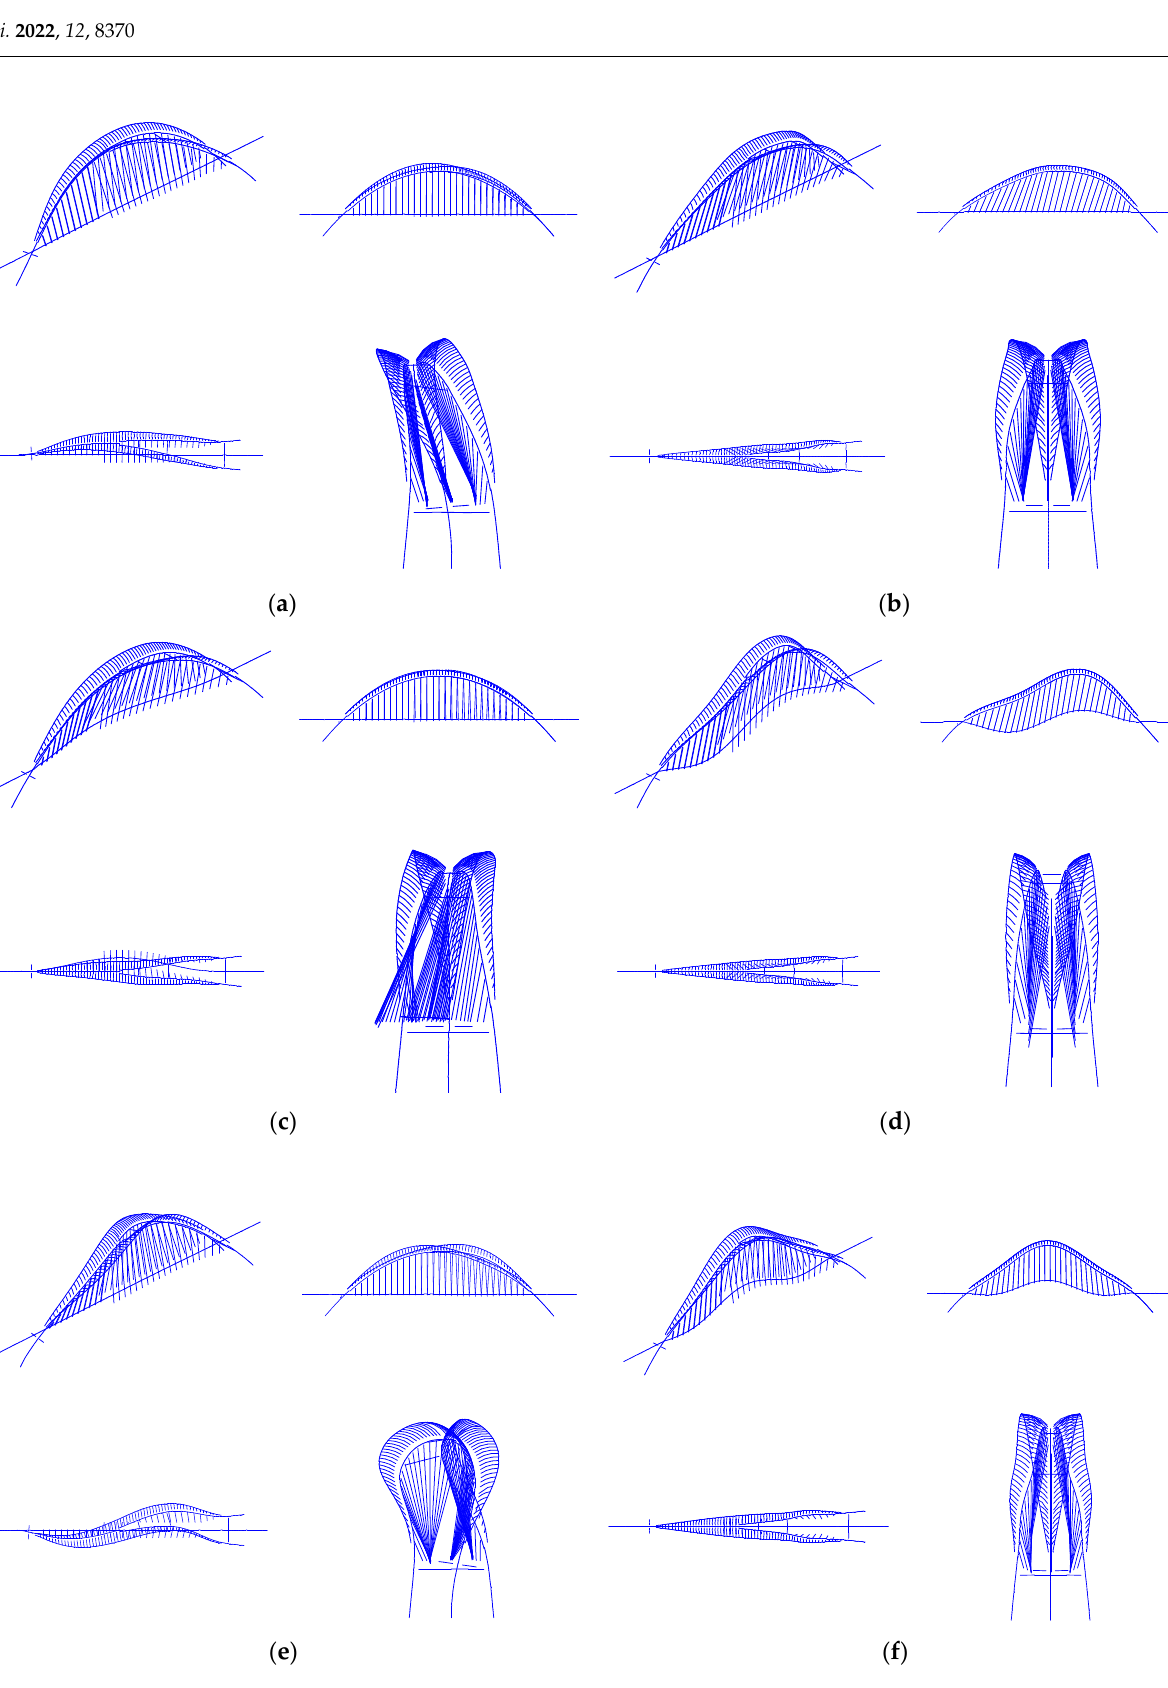
Figure 13. The first six orders of vibration mode characteristics of Y-shaped steel box arch bridge: